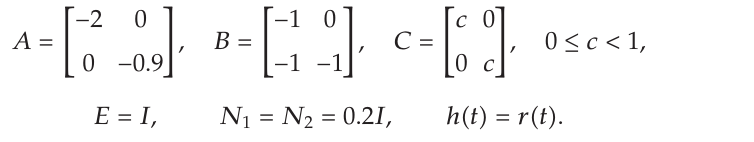
Table 2 lists the comparison of the upper bounds delay for exponential stability of